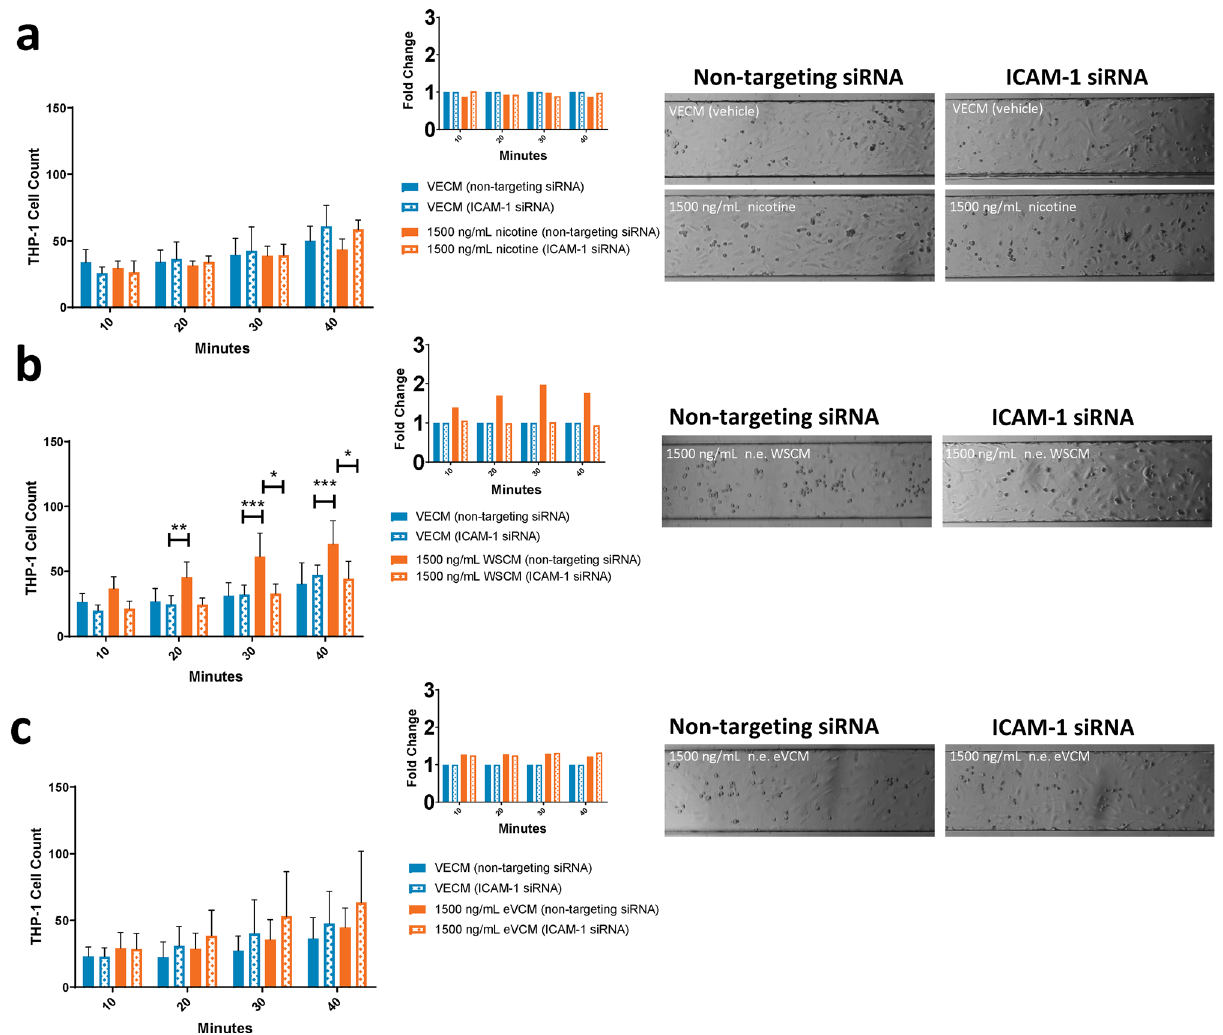
Figure 8. Analysis of ICAM-1 involvement in test article-induced monocyte adhesion to HAECs in the BioFlux microfluidic system. Quantification of monocyte adhesion to HAECs over adhesion periods of 10, 20, 30 and 40 min following 72 h transfection with control or ICAM-1 siRNA and 24 h HAEC exposure to ( a ) nicotine, ( b ) WSCM or ( c ) eVCM, with fold change graphs inset and representative brightfield images of BioFlux microfluidic channels captured after the 40 min adhesion period using a Zeiss Axio Observer.Z1 microscope (×10 magnification). Two-way ANOVA with Dunnett’s multiple comparisons between all treatment conditions. Error bars denote ± SD (n = 6); *p < 0.05 **p < 0.01 ***p <